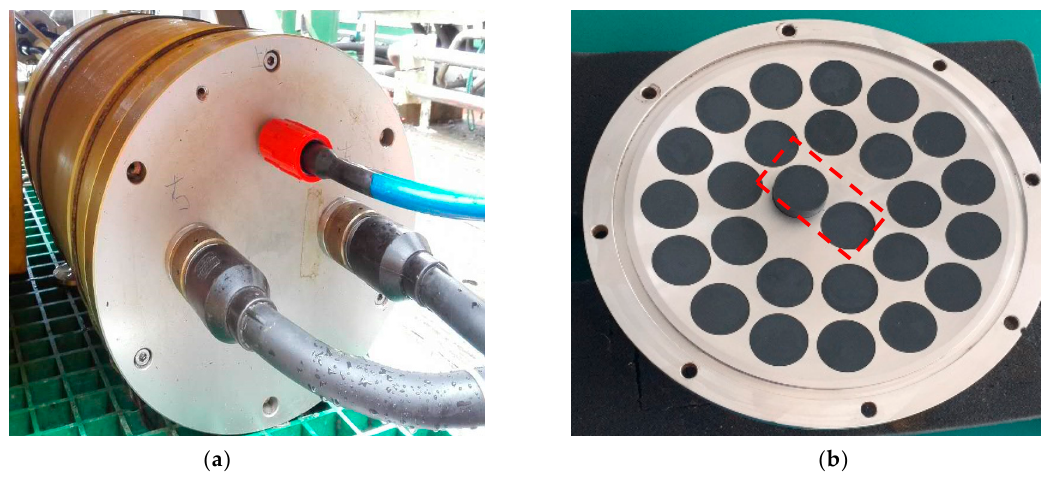
Figure 2. Hardware configuration: ( a ) The electronic processing unit that contains the transmit control board, the filtering and compensation board, and the data collection and controlling board; ( b ) The designed array with receiving transducers marked with the dashed box and the transmitting transducer array (outside the box).